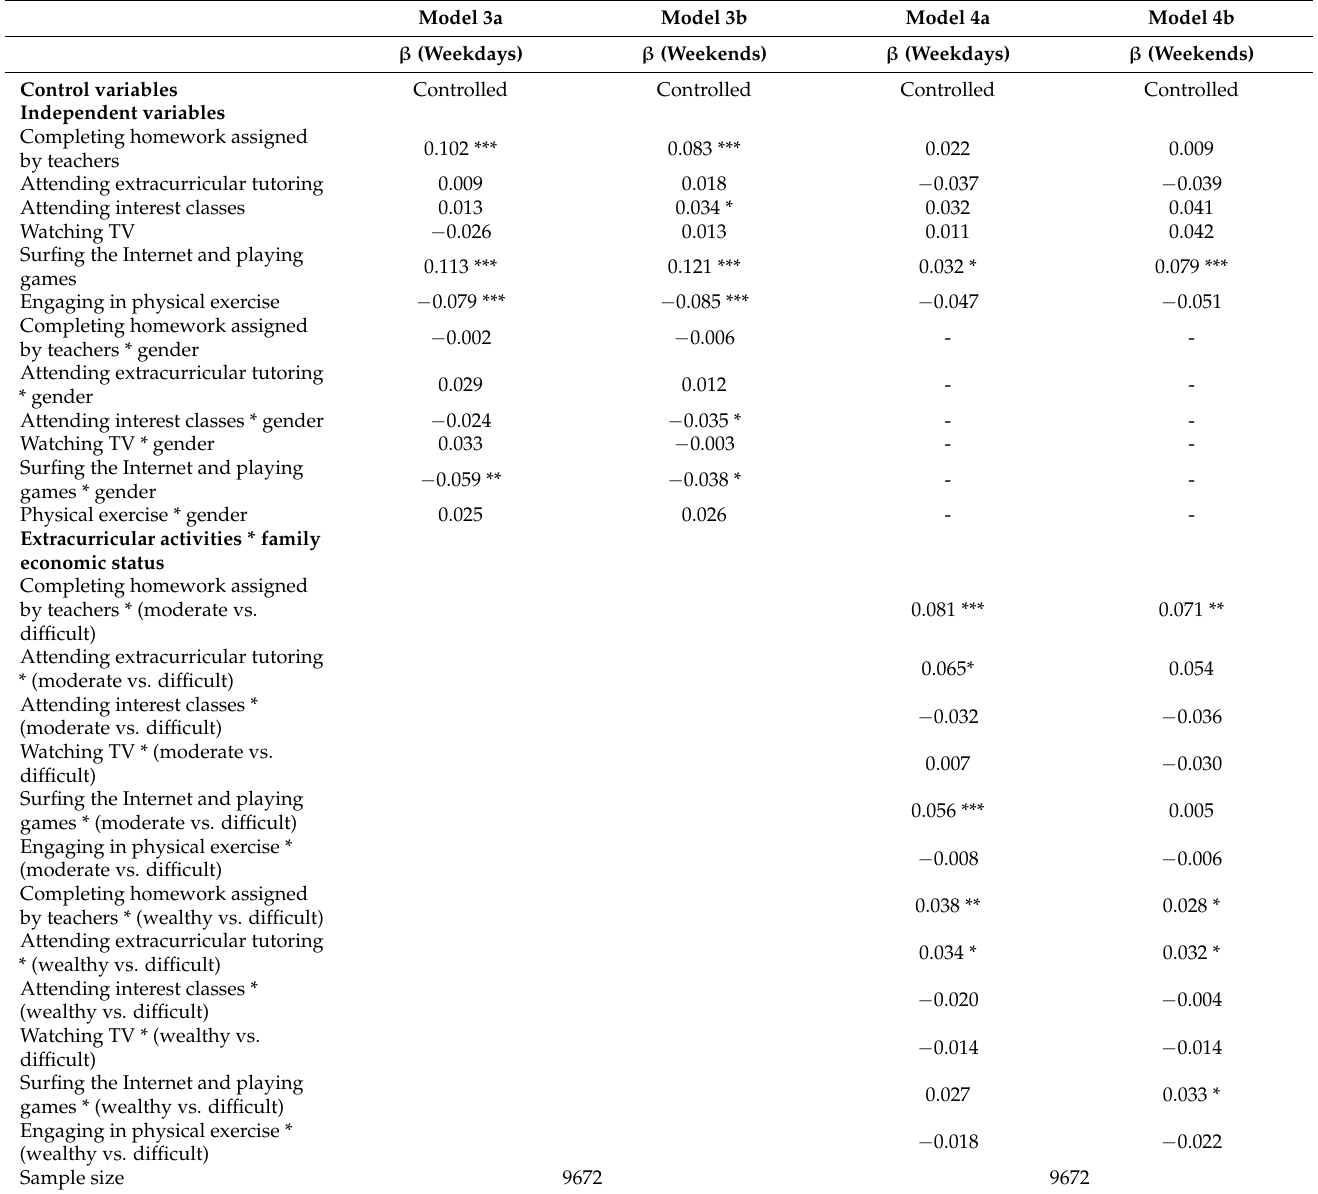
Table 4. Moderating effects of gender and family economic status on the effects of extracurricular activities on depressive